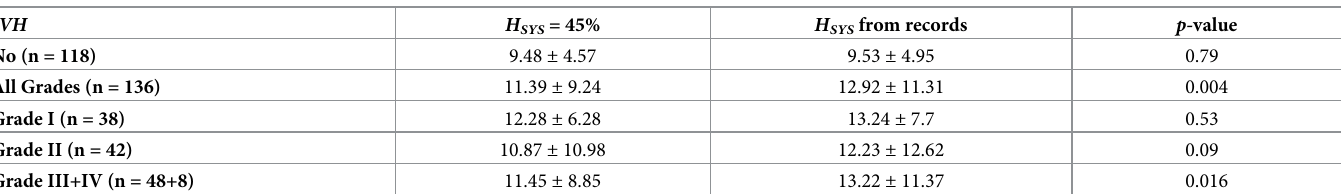
Table 4. Global CBF [ ml/min /100 g ] for different values of H SYS .